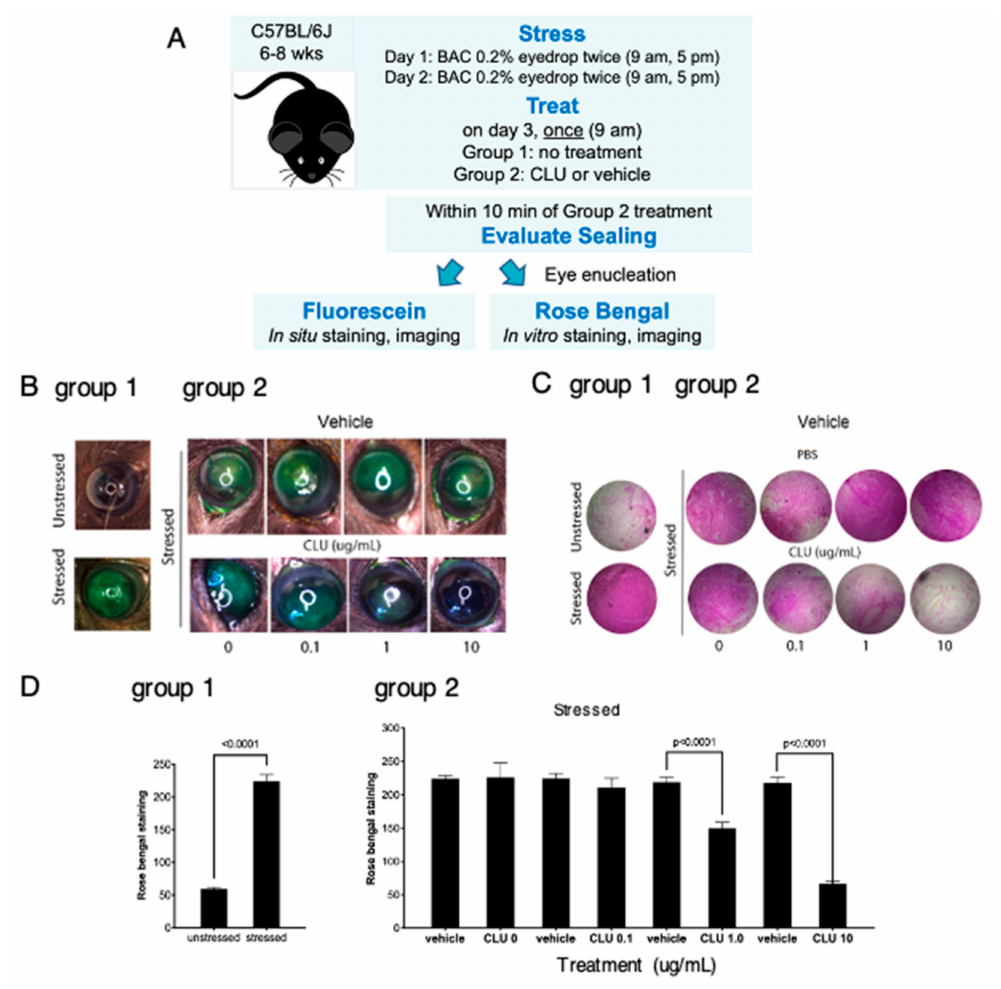
Figure 2. CLU seals the ocular surface barrier damaged by BAC in a concentration-dependent manner. ( A ) One drop of a BAC solution (0.2% dissolved in PBS) was applied to the ocular surface twice (9 a.m., 5 p.m.) on day 1, and twice (9 a.m., 5 p.m.) on day 2. In one group of mice (group 1), right eyes were subjected to the BAC stress protocol, while left eyes were left unstressed. In a second group of mice (group 2), both right and left eyes were subjected to the BAC stress protocol. On the morning of day 3, right eyes of the second group were treated topically with CLU (0.1, 1 or 10 µ g/mL) and left eyes were treated with vehicle alone (PBS). Within 10 min, sealing was assayed in eyes of both groups by staining in situ with fluorescein, or by enucleating eyes and staining in vitro with rose bengal. Shown are representative eyes stained with ( B ) fluorescein or ( C ) rose bengal. ( D ) Quantification of rose bengal staining for all mice for which a representative example is shown in ( C ), expressed as the mean ± standard deviation ( n = 3). Statistical significance was determined by paired T -test and p -values are indicated where